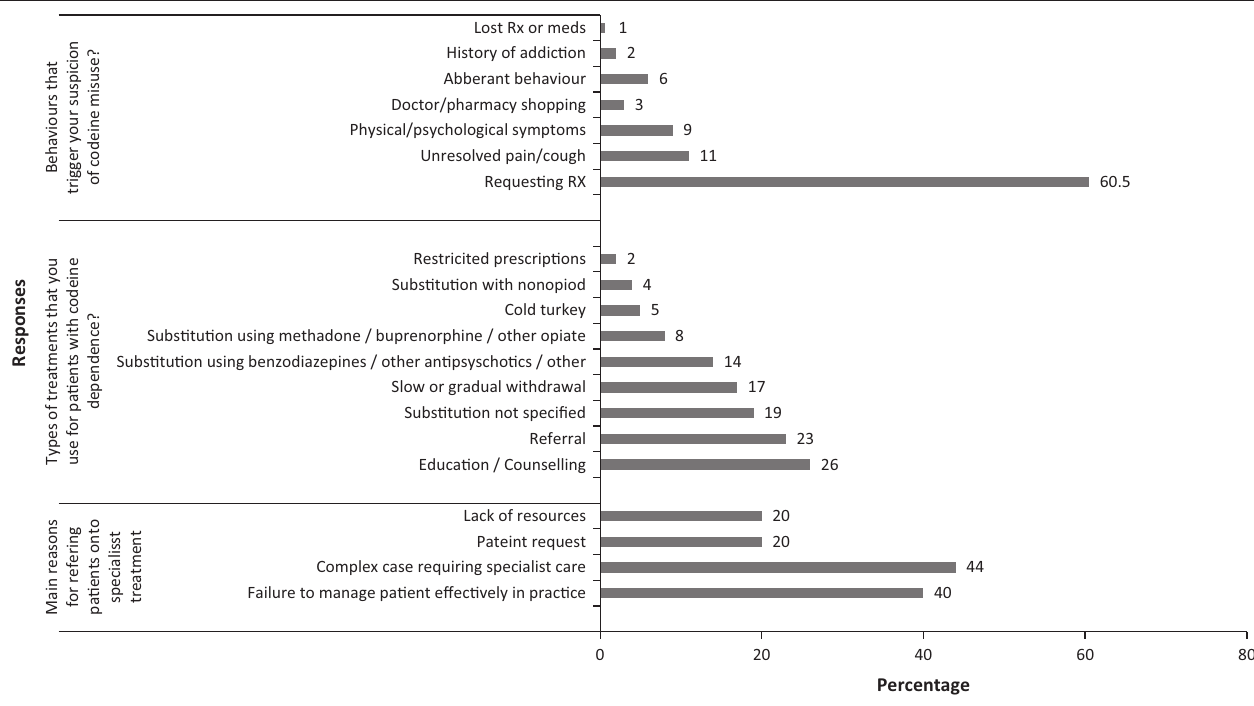
FIGURE 1: The responses in each thematic category as an overall